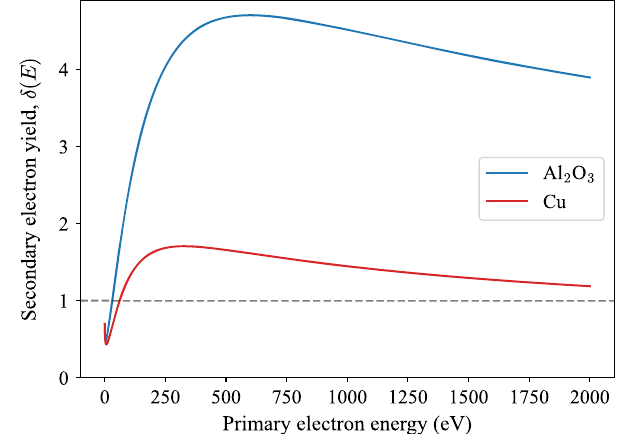
¼ max ¼ 4 . 7 at E ¼ max max